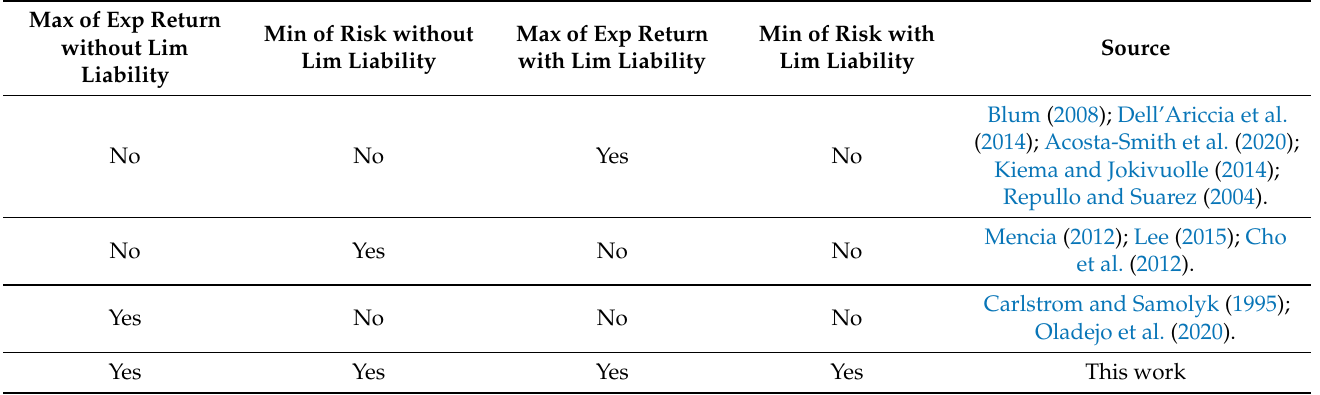
Table 1. Comparative literature highlighting the novelty of the